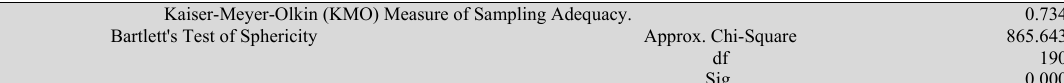
Performance Structure Leadership